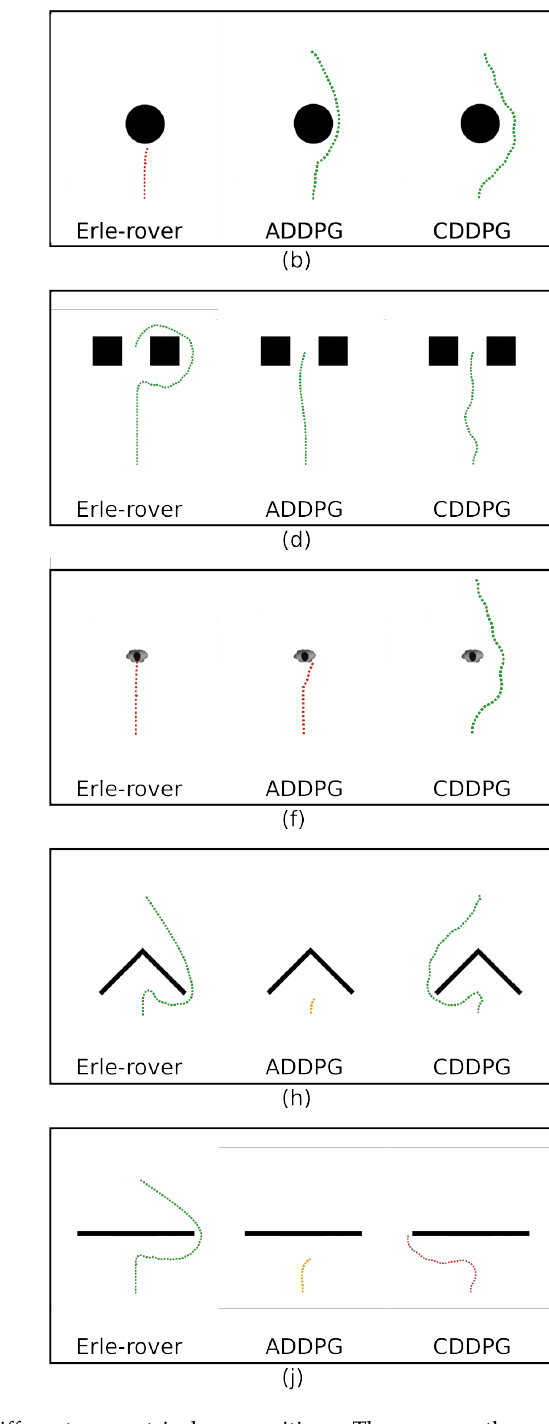
Figure 4. Simulation results with the shapes of different geometrical compositions. The green path designates successful motion. The red path indicates a motion resulting in a collision. The orange path designates a situation where the robot encounters a deadlock. ( a ) Cube, ( b ) sphere, ( c ) 3 thin walls, ( d ) goal point between two cubes, ( e ) a coffee table with a surface on a pole, ( f ) person, ( g ) empty bookshelf, ( h ) concave corner, ( i ) room, ( j ) long